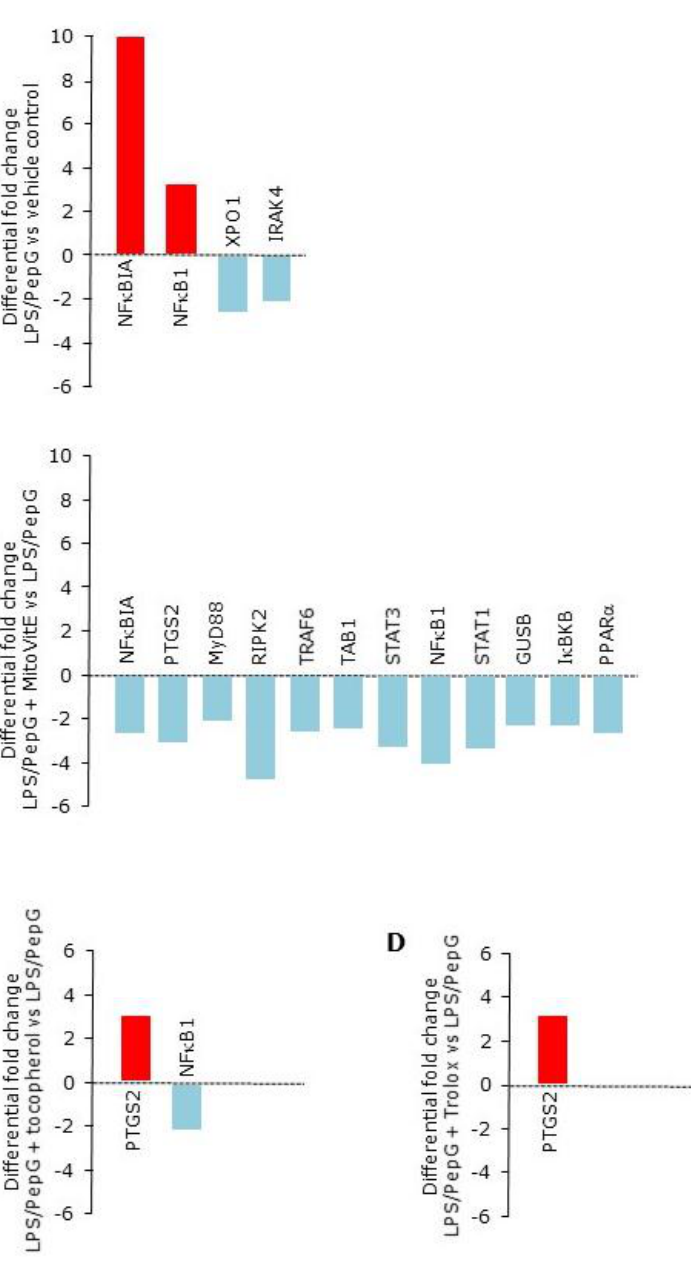
Figure 3. Gene expression. Differential gene expression as mean fold change in endothelial cells showing the effect of ( A ) Lipopolysaccharide plus peptidoglycan (LPS/PepG) compared to vehicle control ( B ) LPS/PepG plus 5 μM MitoVitE compared to LPS/PepG alone ( C ) LPS/PepG plus 5 μM tocopherol compared to LPS/PepG alone or ( D ) LPS/PepG plus 5 μM Trolox compared to LPS/PepG alone. Bars show mean fold changes where p < 0.05. Red = upregulation, blue = downregulation, n = 6. 95% confidence intervals and p values are given in Table 1.